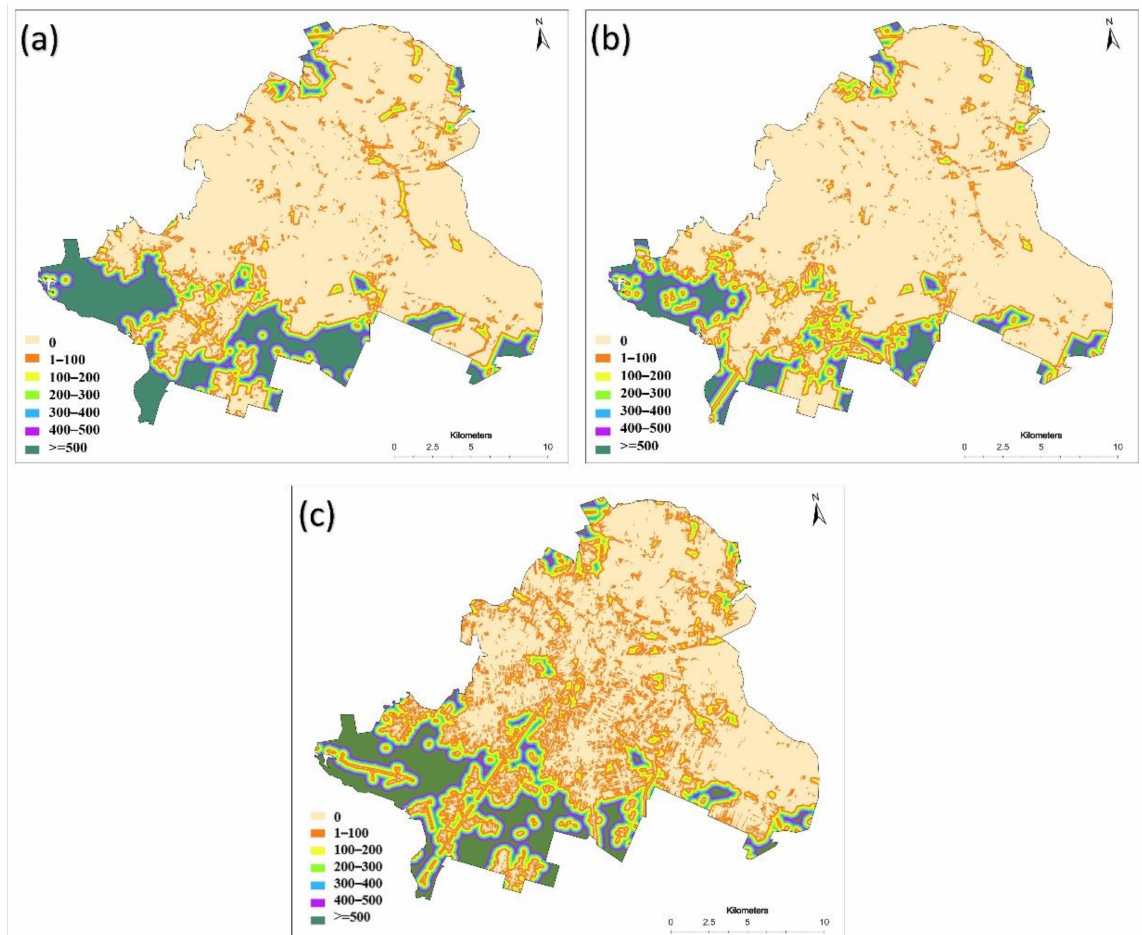
Figure 7. Maps of distribution of distance classes from forest boundary ( a ) 1970 forest and wooded area; ( b ) 1970 forest; ( c ) 2018